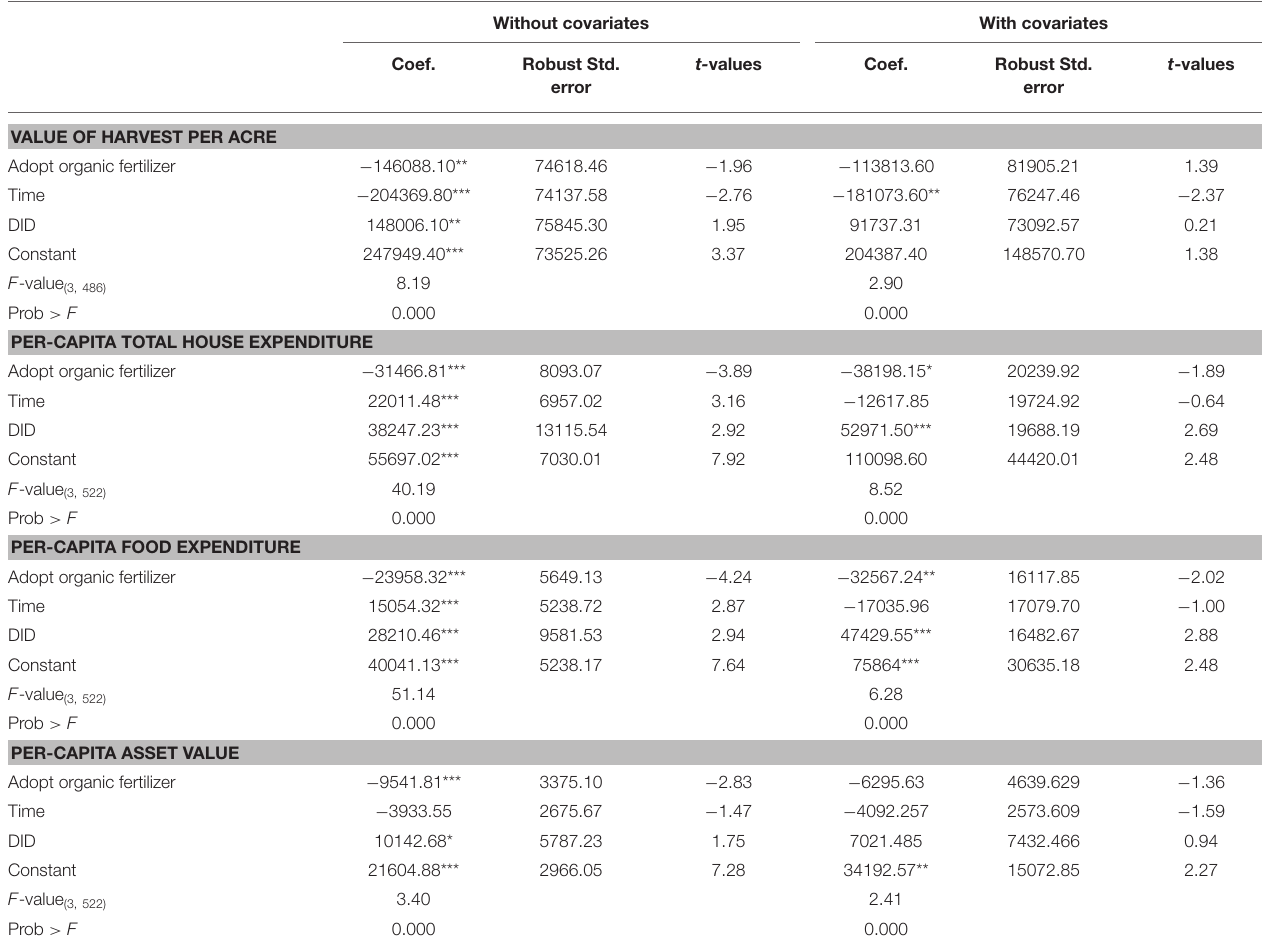
TABLE 8 | Check for Time Effect: Panel difference-in-difference estimates of organic fertilizers adoption.